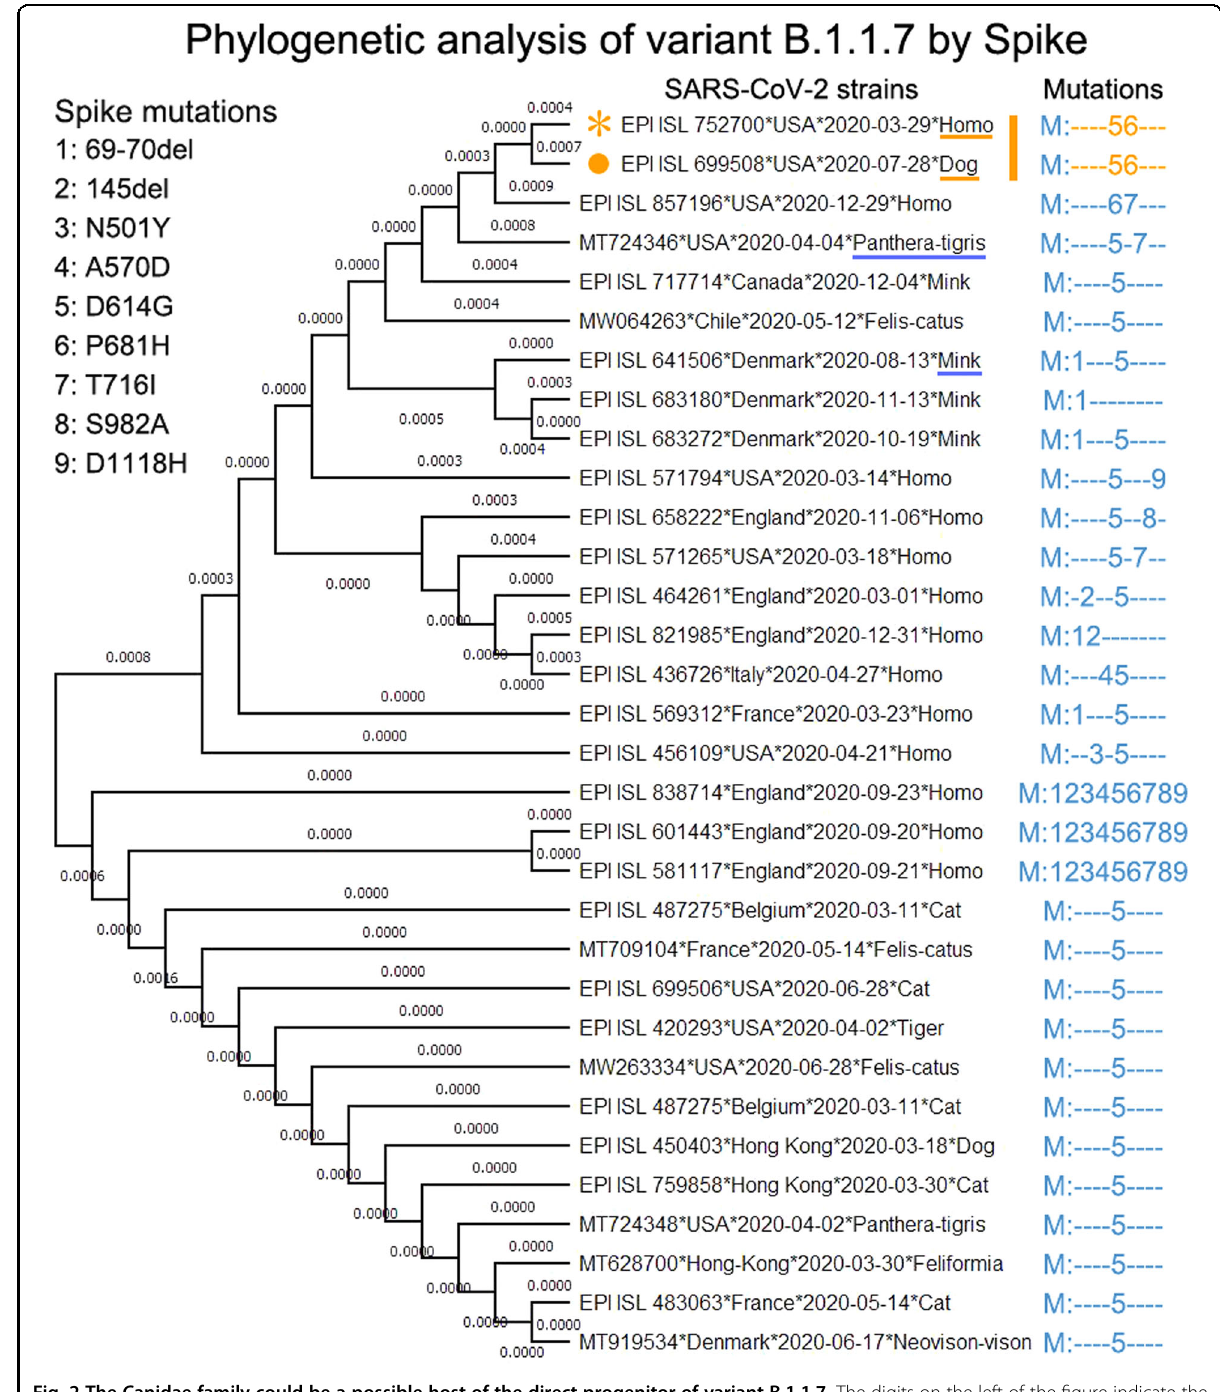
Fig. 2 The Canidae family could be a possible host of the direct progenitor of variant B.1.1.7. The digits on the left of the fi gure indicate the labels of mutations, which correspond with the mutation labels in Fig. 1a. The strains shown in the center of the fi gure contain at least one spike mutation of variant B.1.1.7. Moreover, these strain examples cover all existing SARS-CoV-2 viruses that collected from animal hosts. The strain labeled by orange star corresponds with the star variant in Fig. 1a. The strain with orange solid-round label was collected from a dog on 2020-07-28. Such two strains share the same mutations “ 56 ” and have the minimum phylogenetic distance by MEGA tool. Canidae, Mustelidae or Felidae, especially the Canidae family (e.g., dog) could be a possible host of the direct progenitor of variant B.1.1.7 based on the existing stains collected before the end of